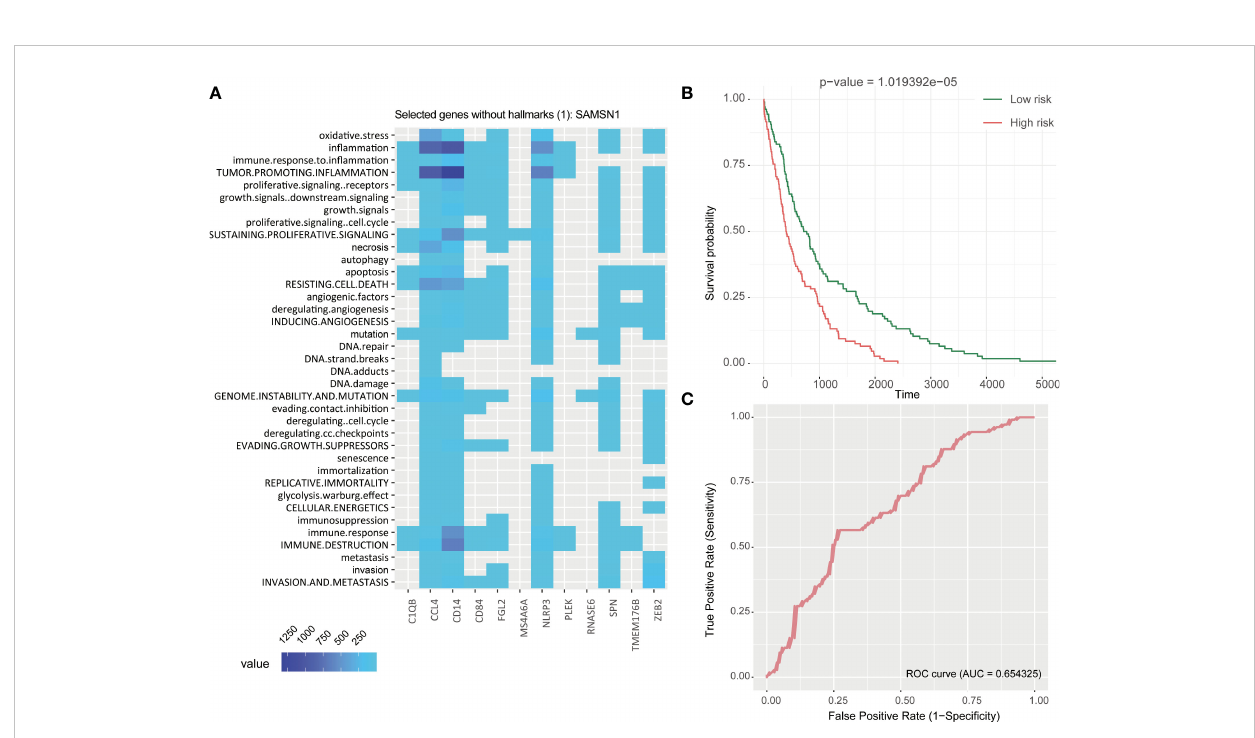
FIGURE 4 Establishment of 13 DRGs RS model. (A) Heatmap of hallmark analysis of 13 genes in the RS model. (B) Kaplan-Meier analysis of the RS in the TCGA NSCLC cohort. Patients were divided into high and low risk groups according to the median RS. (C) ROC curve for predicting 5-year OS in the TCGA NSCLC cohort. DRGs, Differentiation Related Genes; TCGA, The Cancer Genome Atlas; NSCLC, Non-Small Cell Lung cancer; RS, Risk Scores; ROC, Receiver Operating Characteristic.